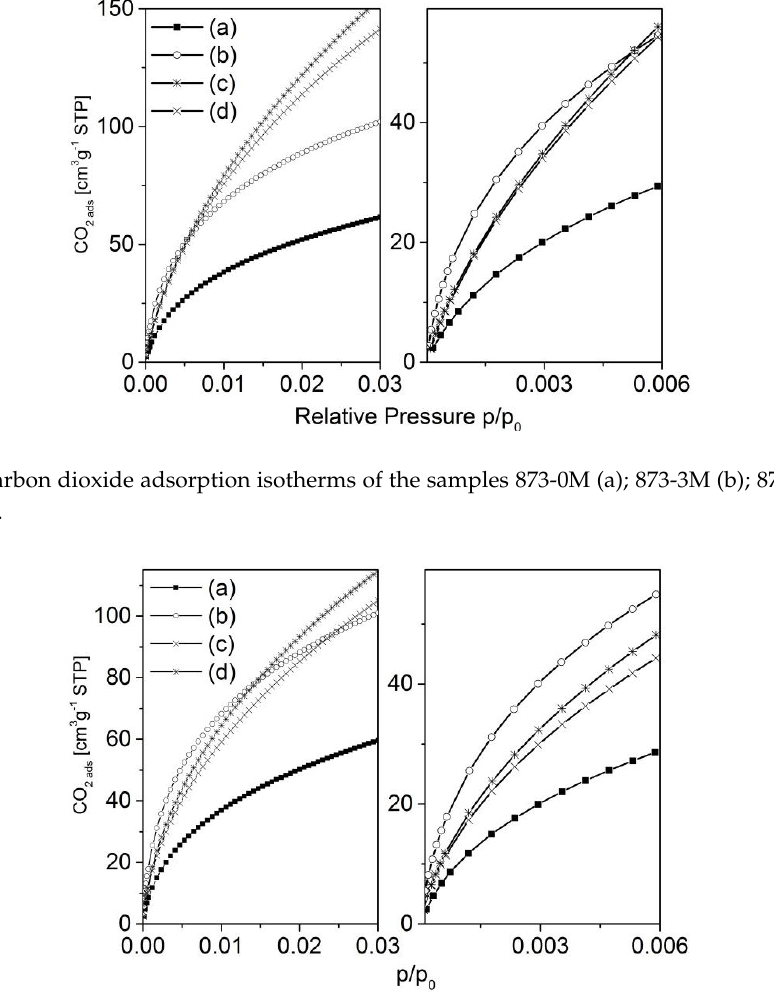
Figure 9. Carbon dioxide adsorption isotherms of the samples 1173-1-0M (a); 1173-1-3M (b); 1173-1-12M (c); 1173-1-16M (d).